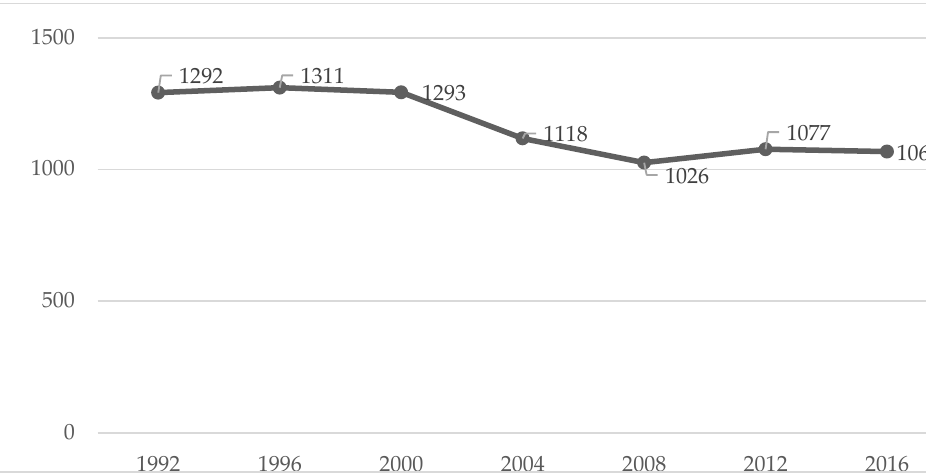
Figure 4. Total medals evolution over all the editions.